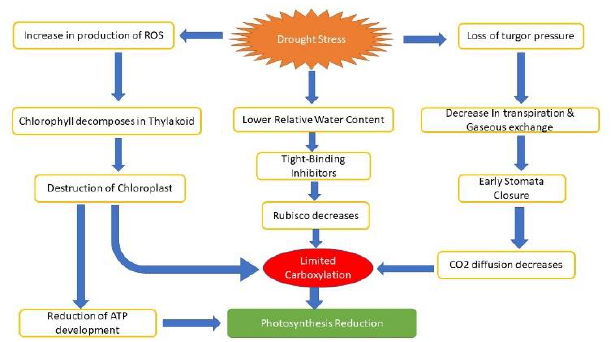
Figure 3: Effect of Drought on Photosynthetic